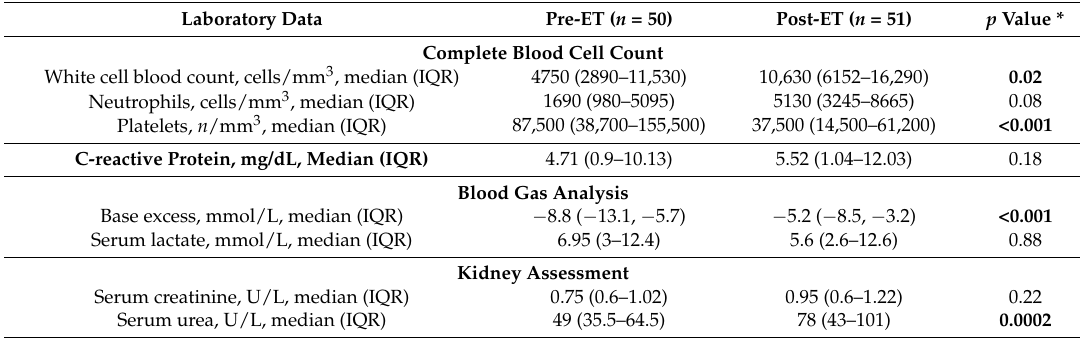
Table 6. Laboratory evaluation before and after exchange transfusion (ET).